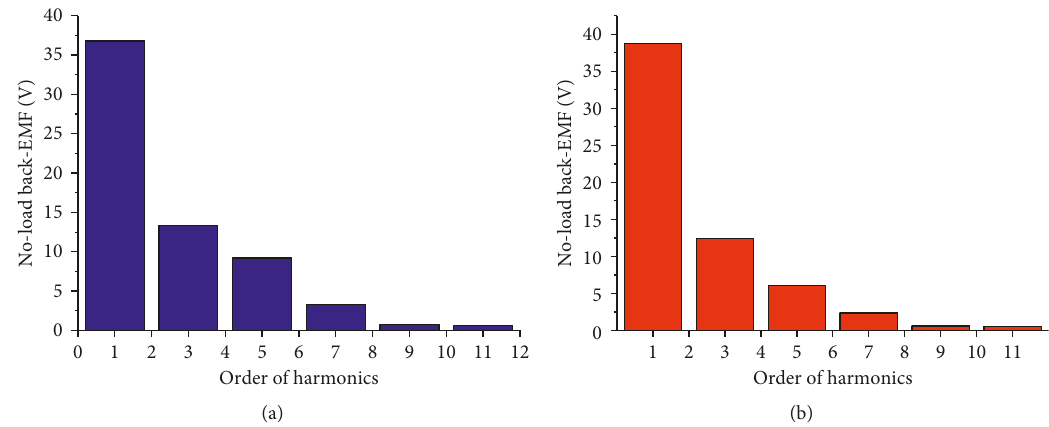
Figure 8: Comparison results of each harmonic content of no-load back EMF. (a) The amplitude of harmonics before optimization. (b) The amplitude of harmonics after optimization.